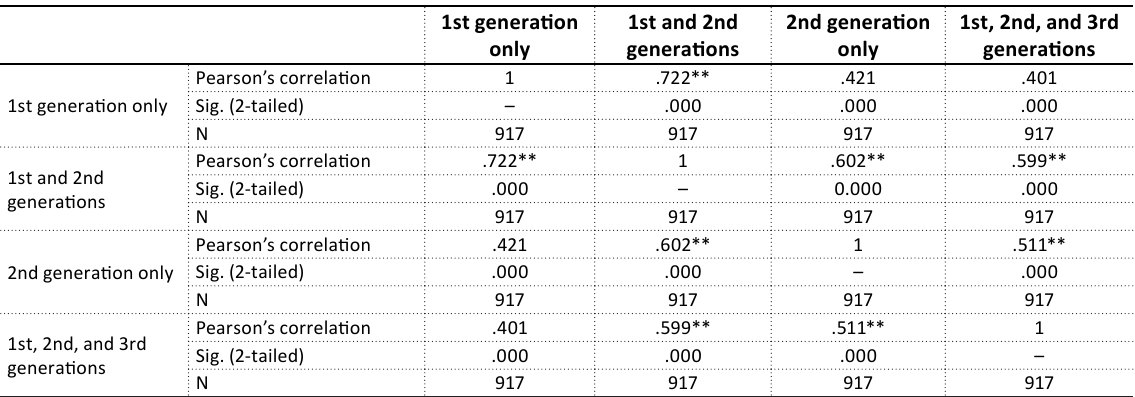
Table 4. Correlation analysis of variables: generational involvement in the management of exporting